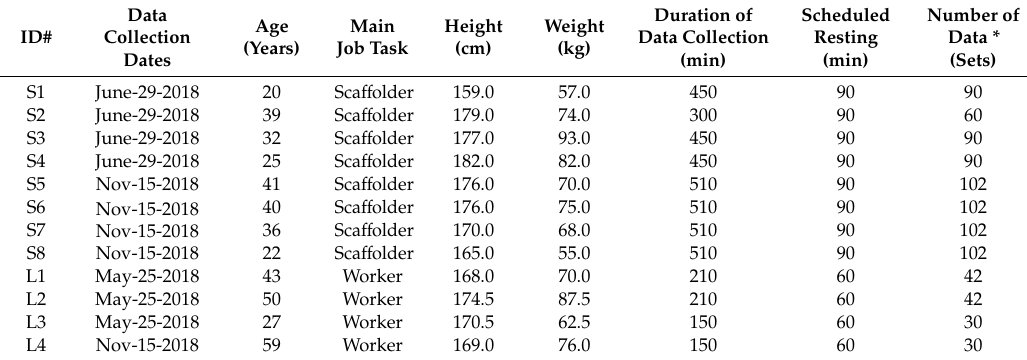
Table 3. Description of the collected data on the